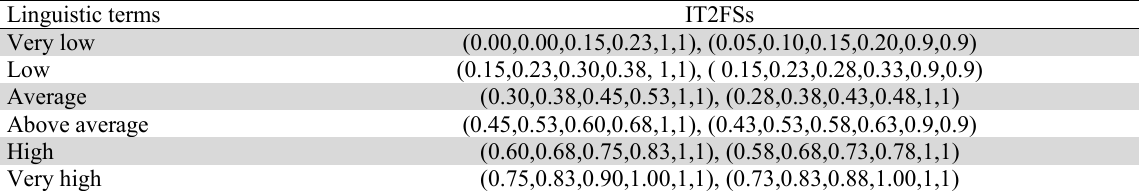
Linguistic terms and IT2FSs for the mini-grid business models evaluation